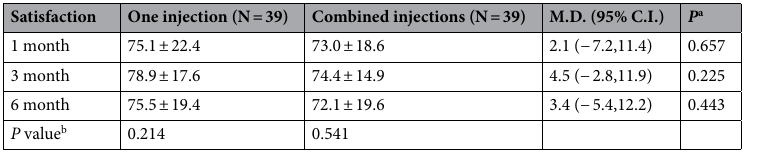
Table 5. Patient satisfaction during the study. The values are given as mean ± the standard deviation M.D. mean difference, C.I. confidence interval. a Between-group difference using independent t-test. b Within-group difference using repeated measure one-way ANOVA. * p value <